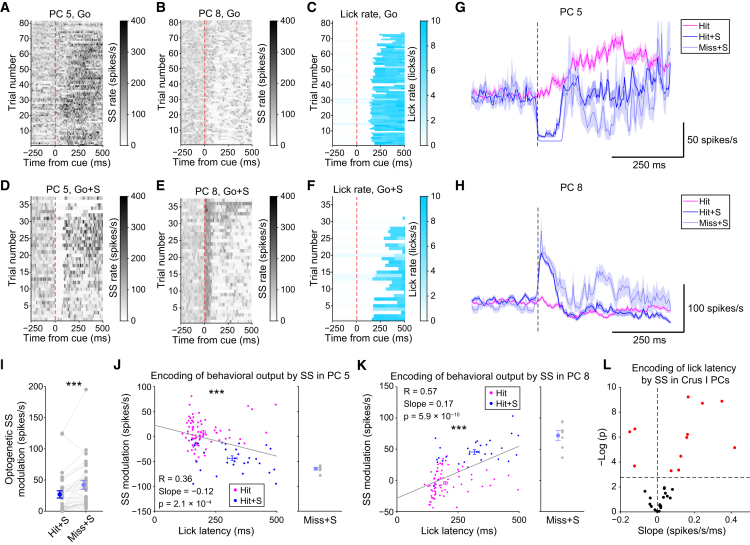
Simple Spike Modulation Contributes to Sensory-Driven Lick Initiation and Its Timing(A) Single-trial simple spike (SS) firing rate after Go cues in the absence of optogenetic stimulation from PC 5 (from Figure 2). The red dotted line represents the onset of the sensory cue.(B) Same as (A) but for PC 8 (from Figure 2).(C) Single-trial lick rate after Go cues without optogenetic stimulation.(D) Same as (A) but for Go cues in the presence of optogenetic stimulation (Go+S).(E) Same as (D) but for PC 8.(F) Same as (C) but for Go+S.(G) Trial-averaged SS rate of PC 5 during Hit trials, Hit + photostimulation (Hit+S), and Miss + photostimulation (Miss+S). A dotted line represents the onset of the sensory cue.(H) Same as (G) but for PC 8.(I) Optogenetically induced absolute changes in trial-averaged SS modulation at 0–100 ms from the onset of sensory stimuli during Hit+S and Miss+S trials compared with that during Hit trials.(J) Linear regression of single-trial lick latency to SS modulation of PC 5 during Hit and Hit+S trials. The SS modulation for Miss+S trials is shown on the right.(K) Same as (J) but for PC 8.(L) Volcano plot for the slope of the linear regression and the significance level individually fit for each PC in Crus I. A horizontal dotted line represents the Bonferroni-corrected threshold p value for significance (p = 0.0017). Red dots represent PCs with significant correlation with lick latency.See also Figure S2 and Table S1.